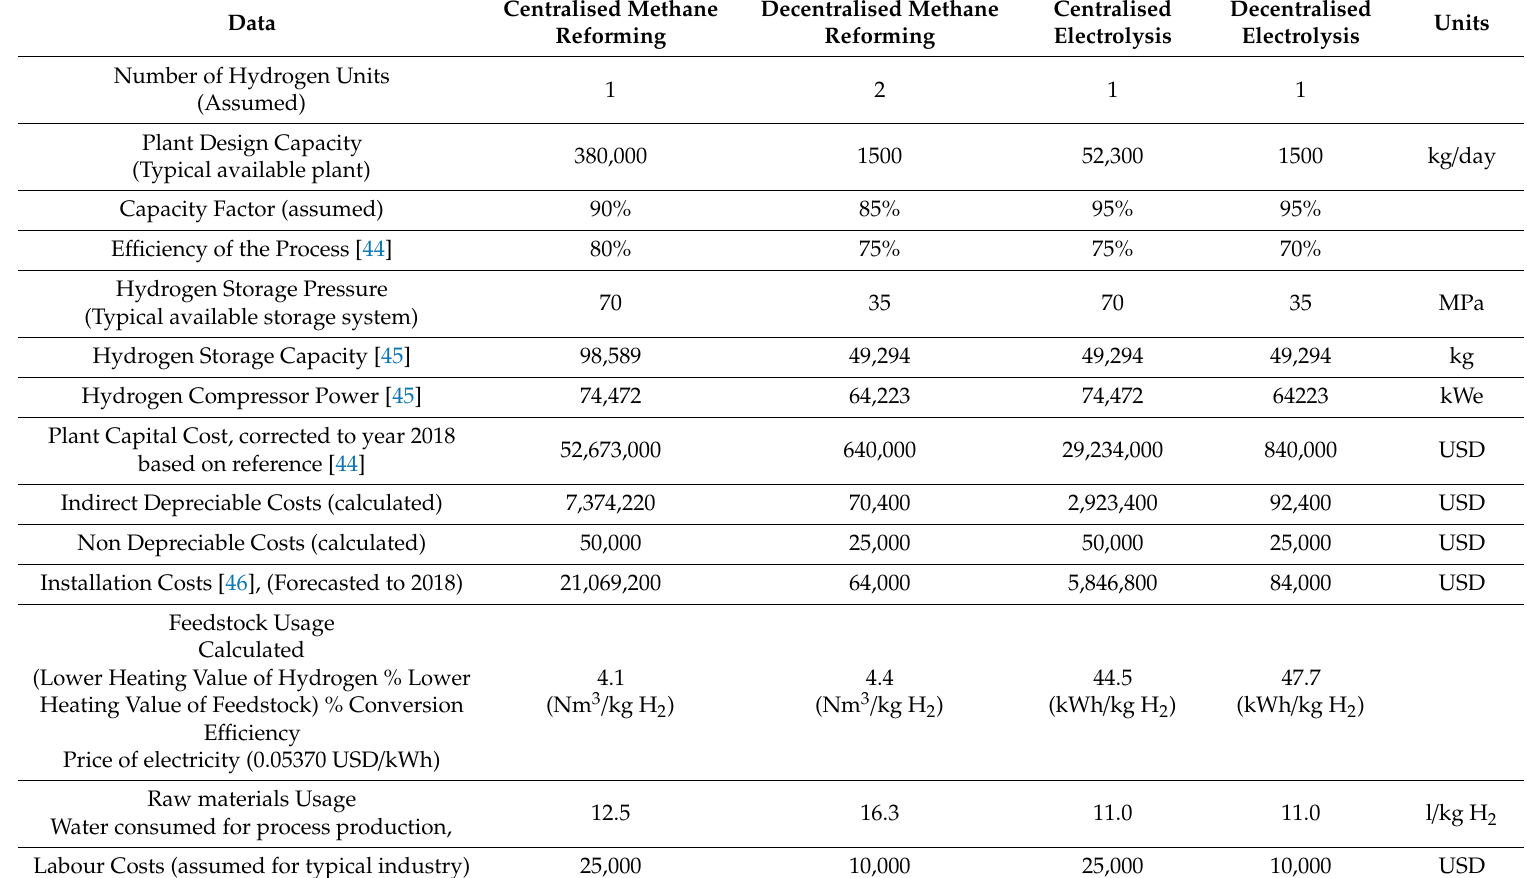
Table A1. Hydrogen production and storage input